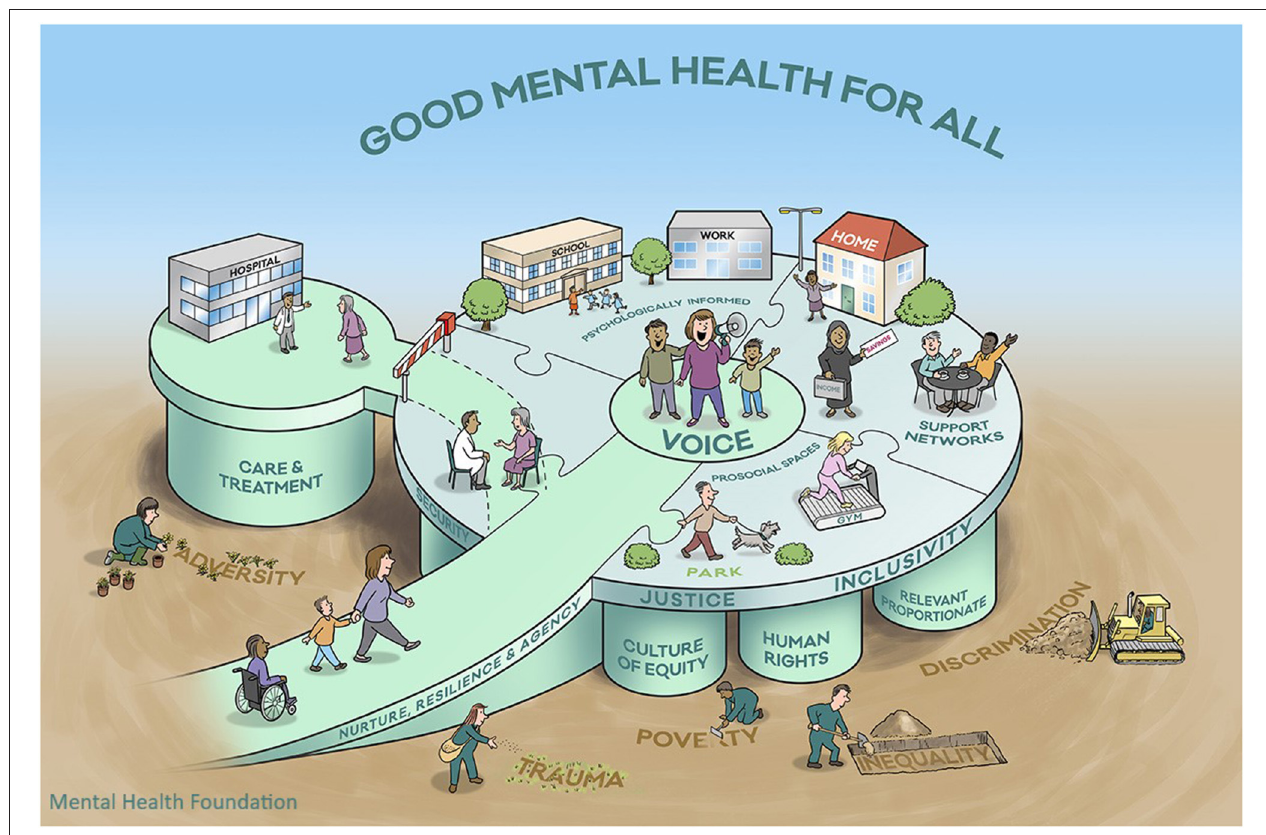
FIGURE 2 | Visualization of a whole-city socio-ecological model for public mental health. (c) Kousoulis, Goldie, Mental Health